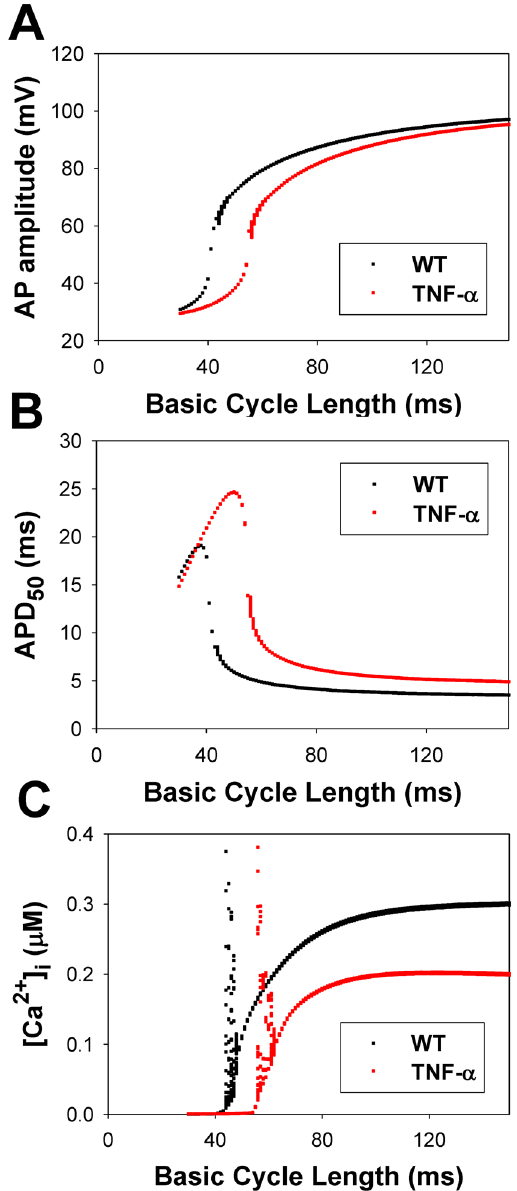
Figure 2. Simulated frequency dependence of AP amplitude (Panel A), AP duration at 50% of repolarization (Panel B), and [Ca 2 + ] i transients (Panel C) for WT (black squares) and TG (red squares) mouse ventricular myocytes at periodic stimulation. Basic cycle length was varied from 30 to 150 ms. AP amplitude, AP durations, and [Ca 2 + ] i transients were calculated in time interval from 48 to 50 s. I Na with slow